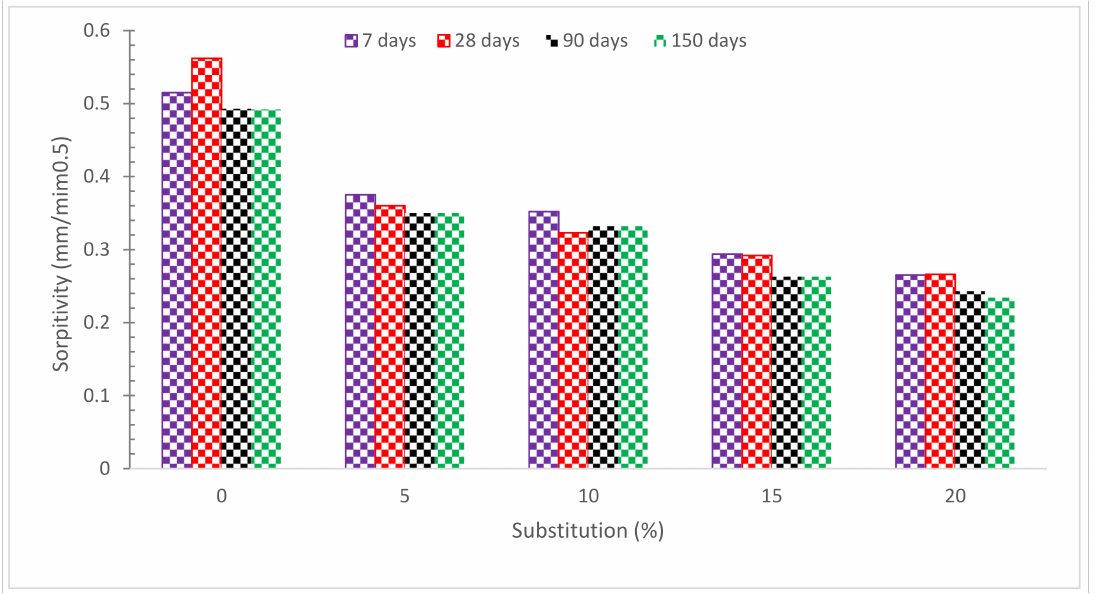
Figure 17. Sorptivity of Concrete